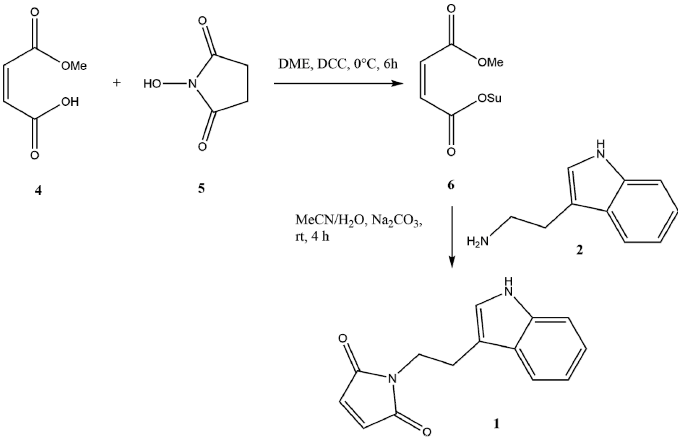
Figure 3. Synthetic route to 1 using a solvent-based approach via activated maleic acid reactant. DME: